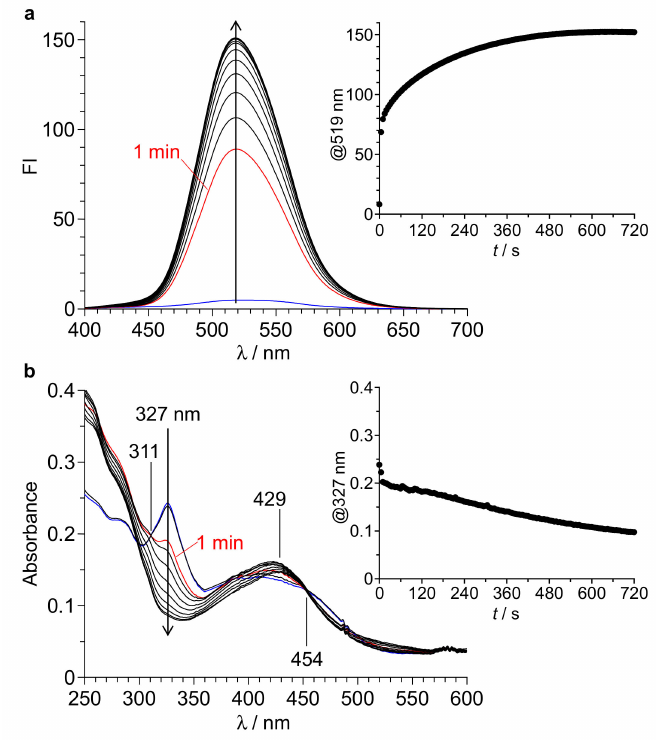
Figure 3. ( a ) Change in fluorescence spectra of 1 in a bu ff ered water / MeCN mixture (8 / 2 v / v , pH